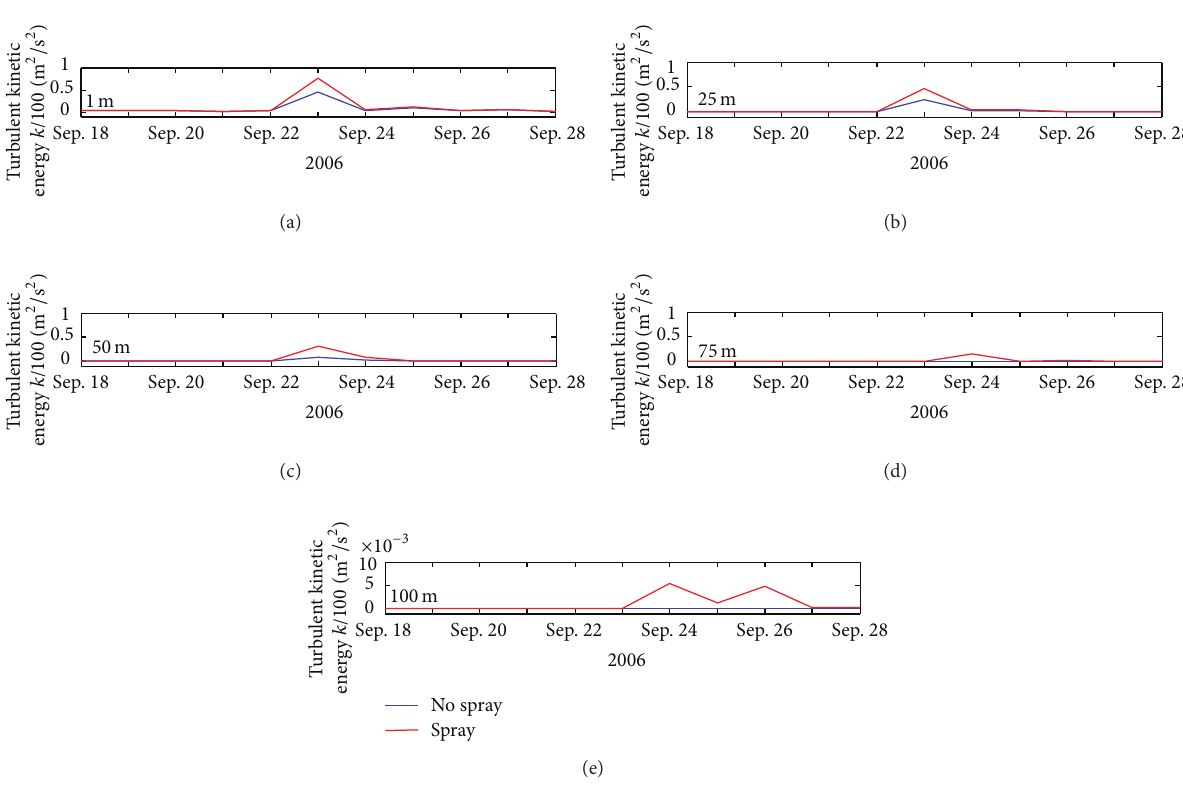
Figure 13: The same as Figure 11, but for the total turbulent kinetic energy 𝑘